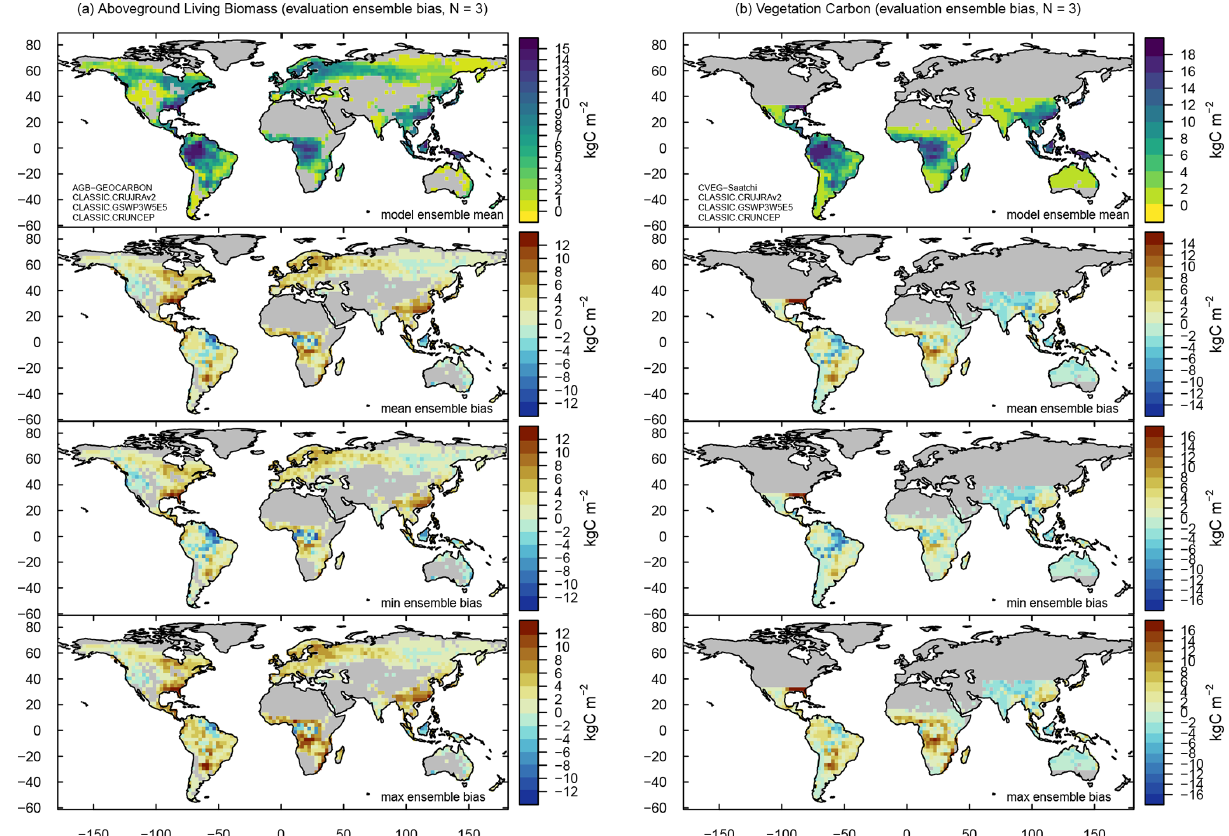
Figure A22. Same as Fig. 7 but for (a) above-ground living biomass and (b) vegetation carbon in the